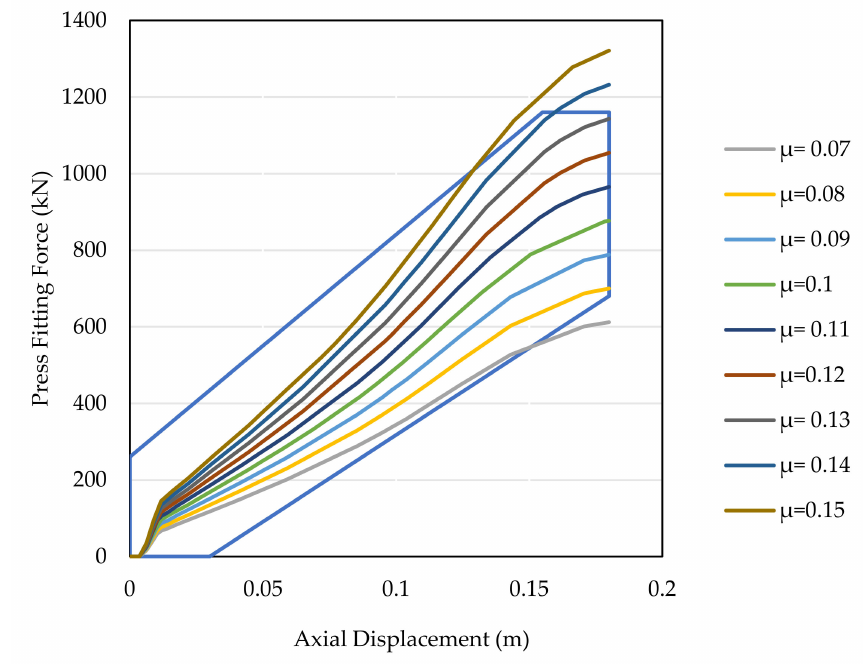
Figure 12. Press-fitting curves with friction coefficient as a